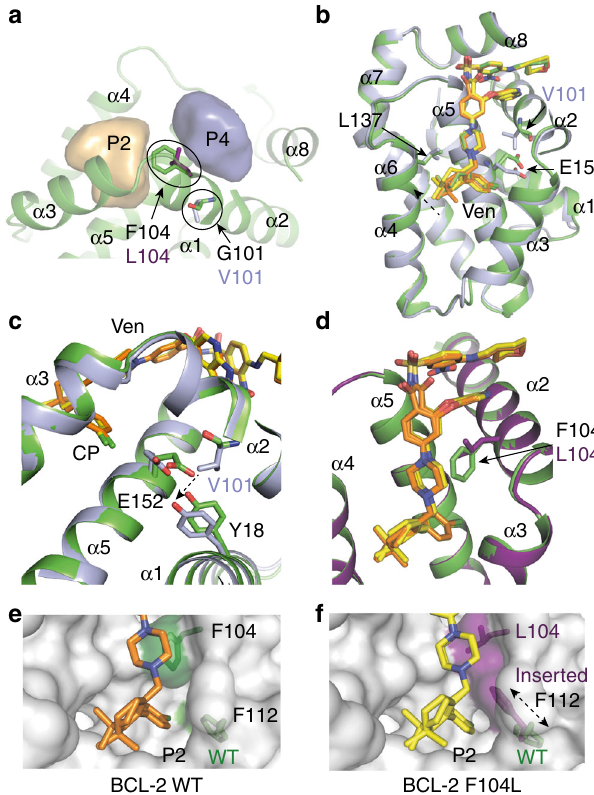
Fig. 2 BCL-2 mutations and venetoclax binding. a location of G101V and F104L mutants relative to the BCL-2 groove, α 1 – 8 helices and P2 (orange) and P4 (blue) pockets. Pockets volumes were de fi ned by venetoclax (Ven) chlorophenyl (CP) for P2 pocket and azaindole ring for P4 pocket, see methods for further details. b , c Overlay of BCL-2 WT and BCL-2 G101V bound to venetoclax. d Overlay of BCL-2 WT and BCL-2 F104L bound